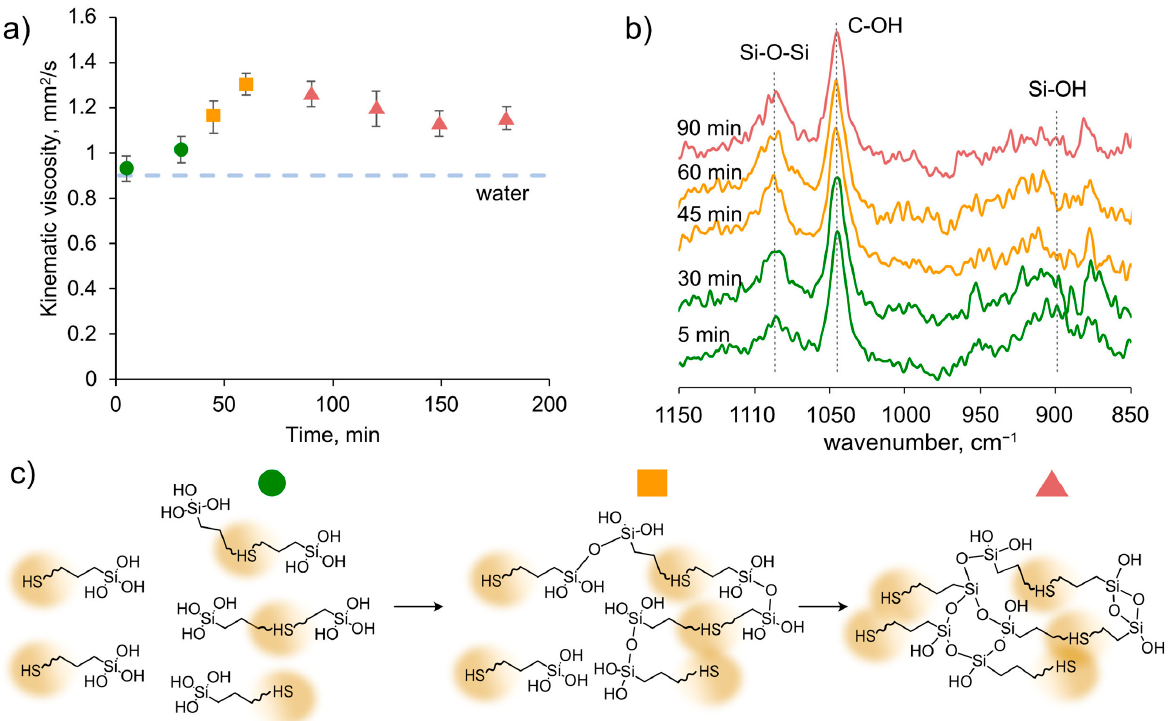
Figure 4. Dependence of kinematic viscosity on time for HS–ASQ:100 5 g/L at 25 °C ( a ), the corresponding IR spectra ( b ), and the HS–ASQ aging scheme ( c ).